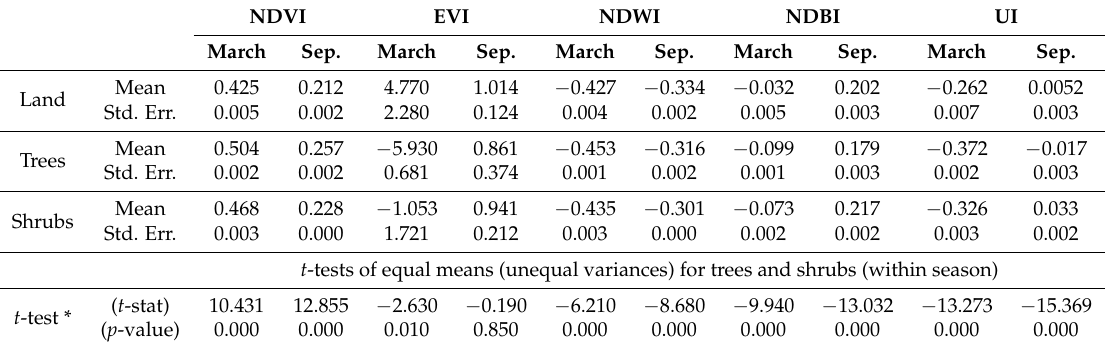
Table A6. Statistics for NDVI, EVI, NDWI, NDBI and UI spectral indices (calculated with Landsat 8), per season, with comparison for trees and shrubs.